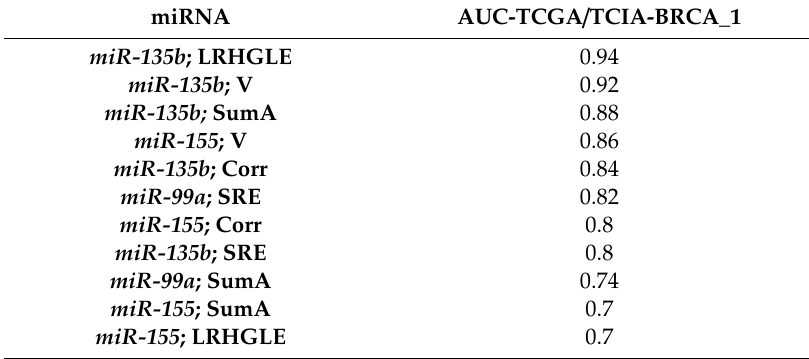
Results of the classification of pairwise combination miRNA / imaging features in TCGA /